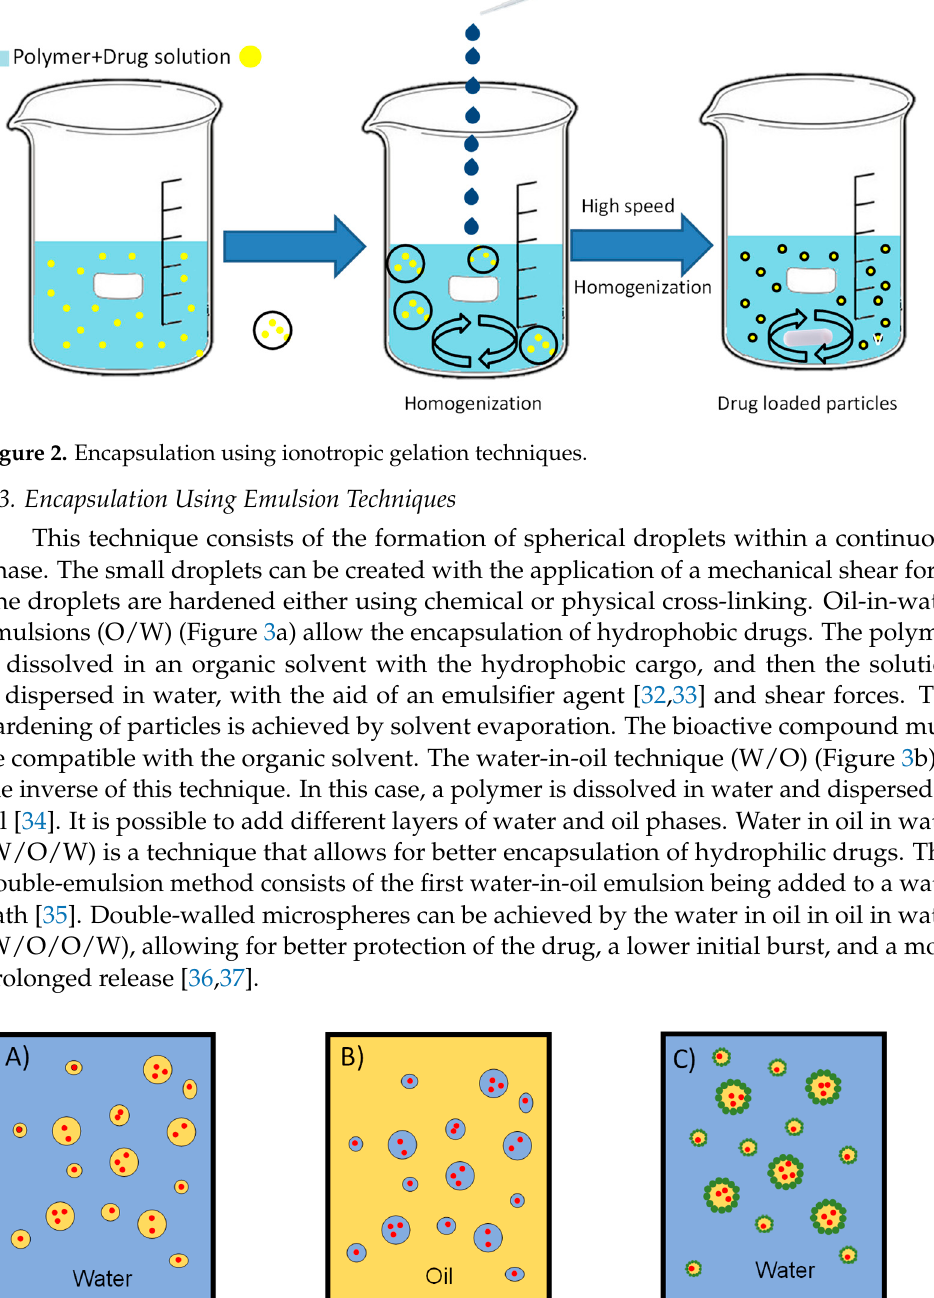
Figure 2. Encapsulation using ionotropic gelation techniques.